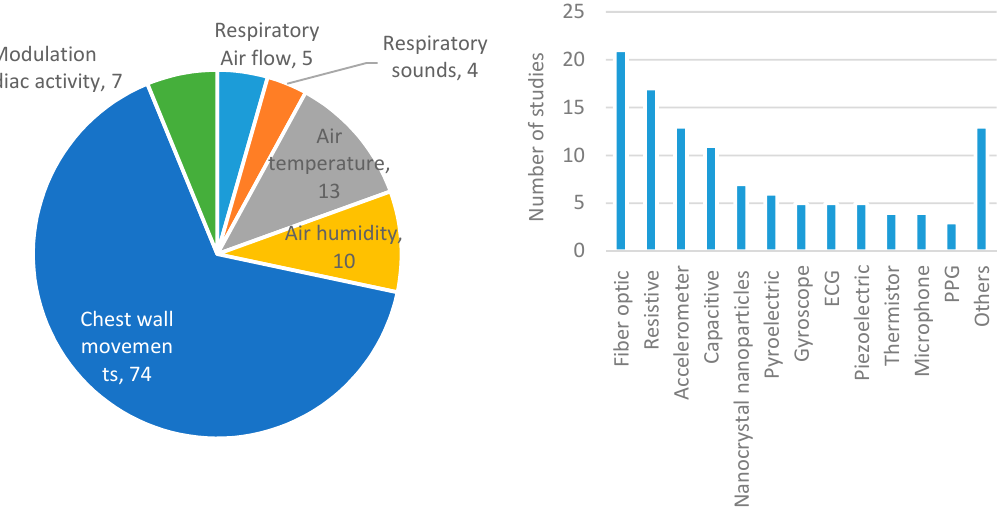
Figure 6. Distribution of sensing techniques ( left ) and sensors ( right ) used in the studies of the wearable category.